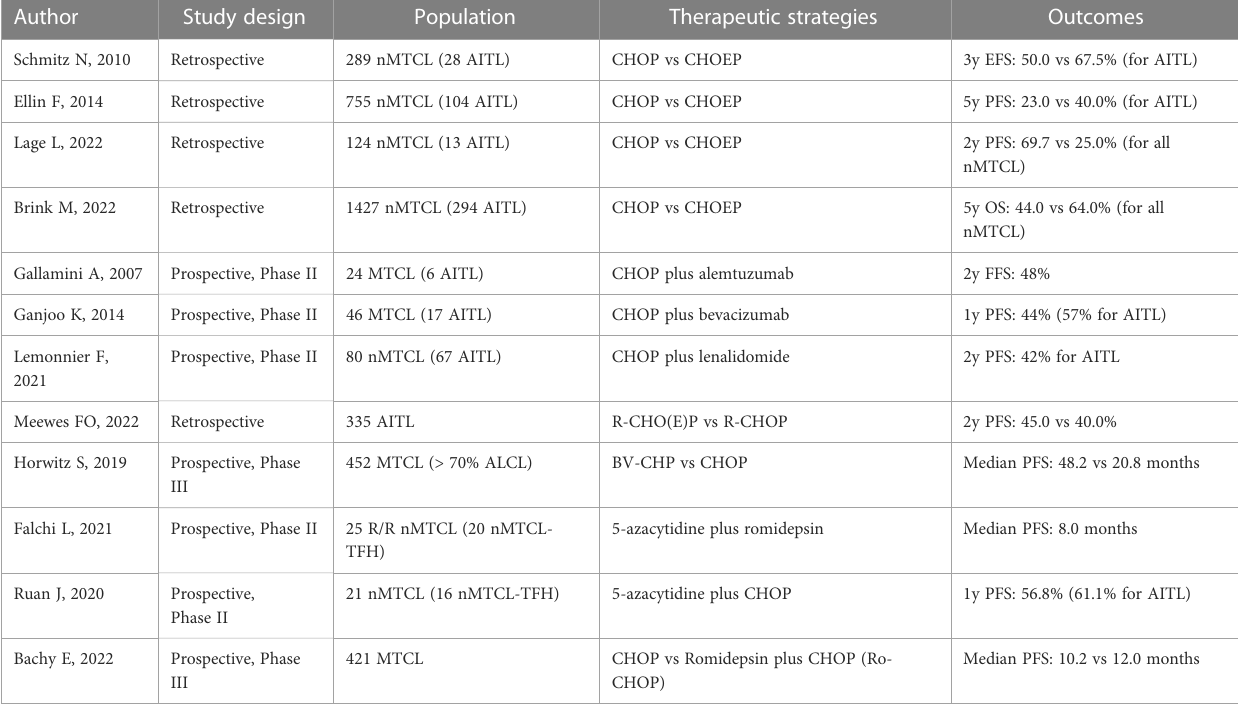
TABLE 1 Main studies evaluating alternative therapeutic strategies to the CHOP regimen for MCTL in different clinical